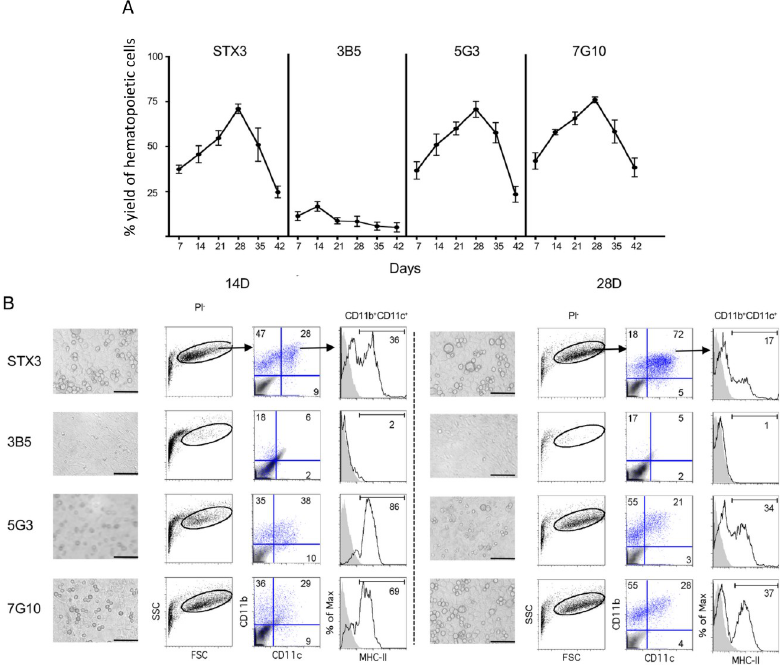
Fig 1. Stromal co-cultures support hematopoiesis. Co-cultures were established in triplicate by overlay of T and B cell depleted splenocytes at 0.5–1 x 10 5 cells/ml over near-confluent stroma. Controls comprised stroma alone and ‘T/B depleted splenocytes’. (A) Co-cultures were established with 3B5, 5G3, 7G10 and STX3 stroma. Non-adherent cells were collected at 7-day intervals for estimation of percent (%) live cell recovery relative to input cell number using trypan blue exclusion for cell counting. Data represent mean ± standard error (n = 3). Cell production by 3B5 compared with all other stroma was statistically significant at each time point (p � 0.05). (B) Co-cultures were established over 5G3 stroma. Cell production was compared and photographed at 14 and 28 days under brightfield (Objective 20x, bar 250 μ m). Non-adherent cells were collected and stained with antibodies specific for CD11c, CD11b and MHC-II, or with isotype controls to set gates. Propidium iodide (PI) staining prior to flow cytometry allowed gating of PI - (live) cells and FSC and SSC analysis was used to gate large (FSC hi ) cells for subsequent analysis. Numbers shown in quadrants represent percent positive cells. Culture of stroma alone have no cell production (not